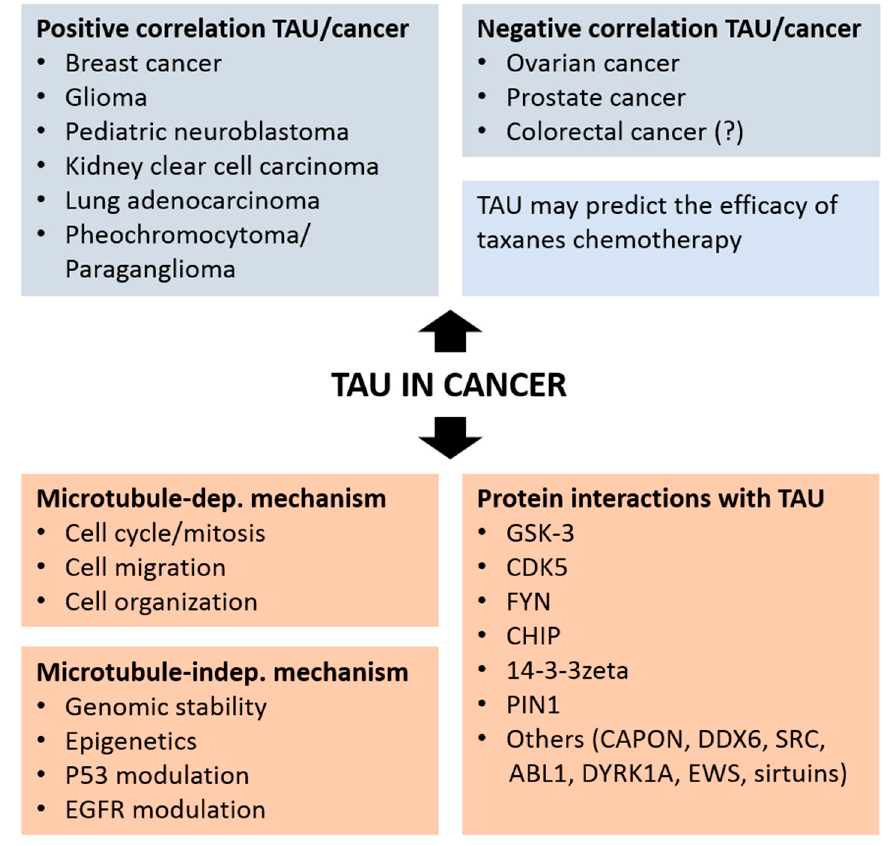
Figure 2. Positive and negative association of TAU expression with different type of cancers (top panels) and mechanisms and protein interactions associating TAU to cancer.